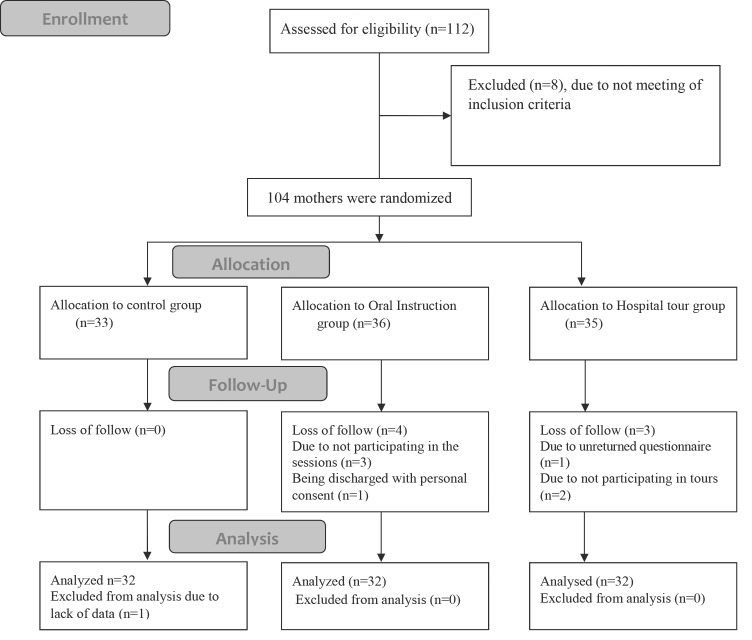
 Consort flow diagram of participants